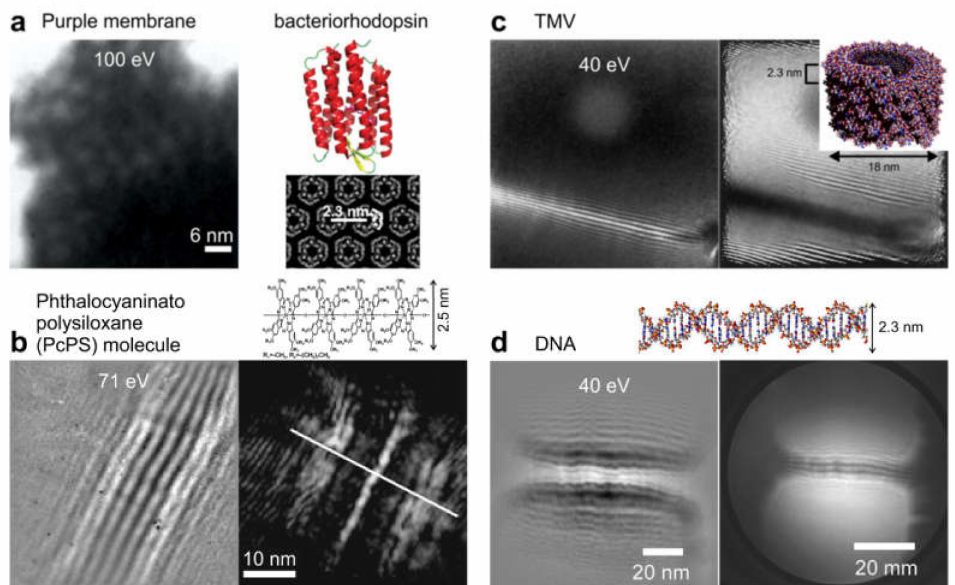
Figure 21. Low-energy in-line holography imaging of individual macromolecules. In each case, the left image shows experimental holograms, and the right shows the corresponding reconstructions. ( a ) Purple membrane (reprinted from [84], with permission from Elsevier). ( b ) Phthalocyaninato polysiloxane (PcPS) molecule (reprinted with permission from [28], copyright 1998, American Vacuum Society). ( c ) Tobacco mosaic virus (TMV) (reprinted from [88], with permission from Elsevier). ( d ) DNA molecules